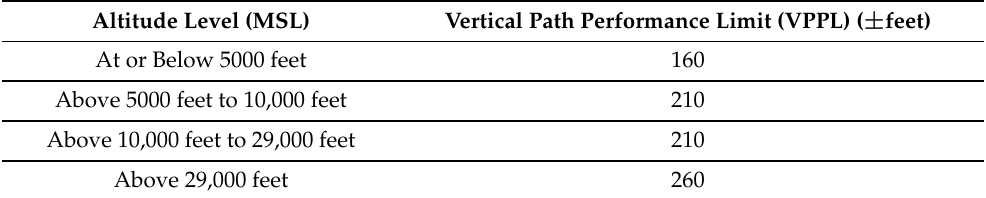
Table 1. VPPL specifies the maximum tolerable altitude error of the altitude measurement system for various phases of flight. Adapted with premission from Table 2-1 in RTCA DO-236C ©RTCA/ED-75D ©EUROCAE. Used with permission. All rights reserved [2,3]. Altitude Level (MSL) Vertical Path Performance Limit (VPPL) ( ± feet) At or Below 5000 feet 160 Above 5000 feet to 10,000 feet 210 Above 10,000 feet to 29,000 feet 210 Above 29,000 feet